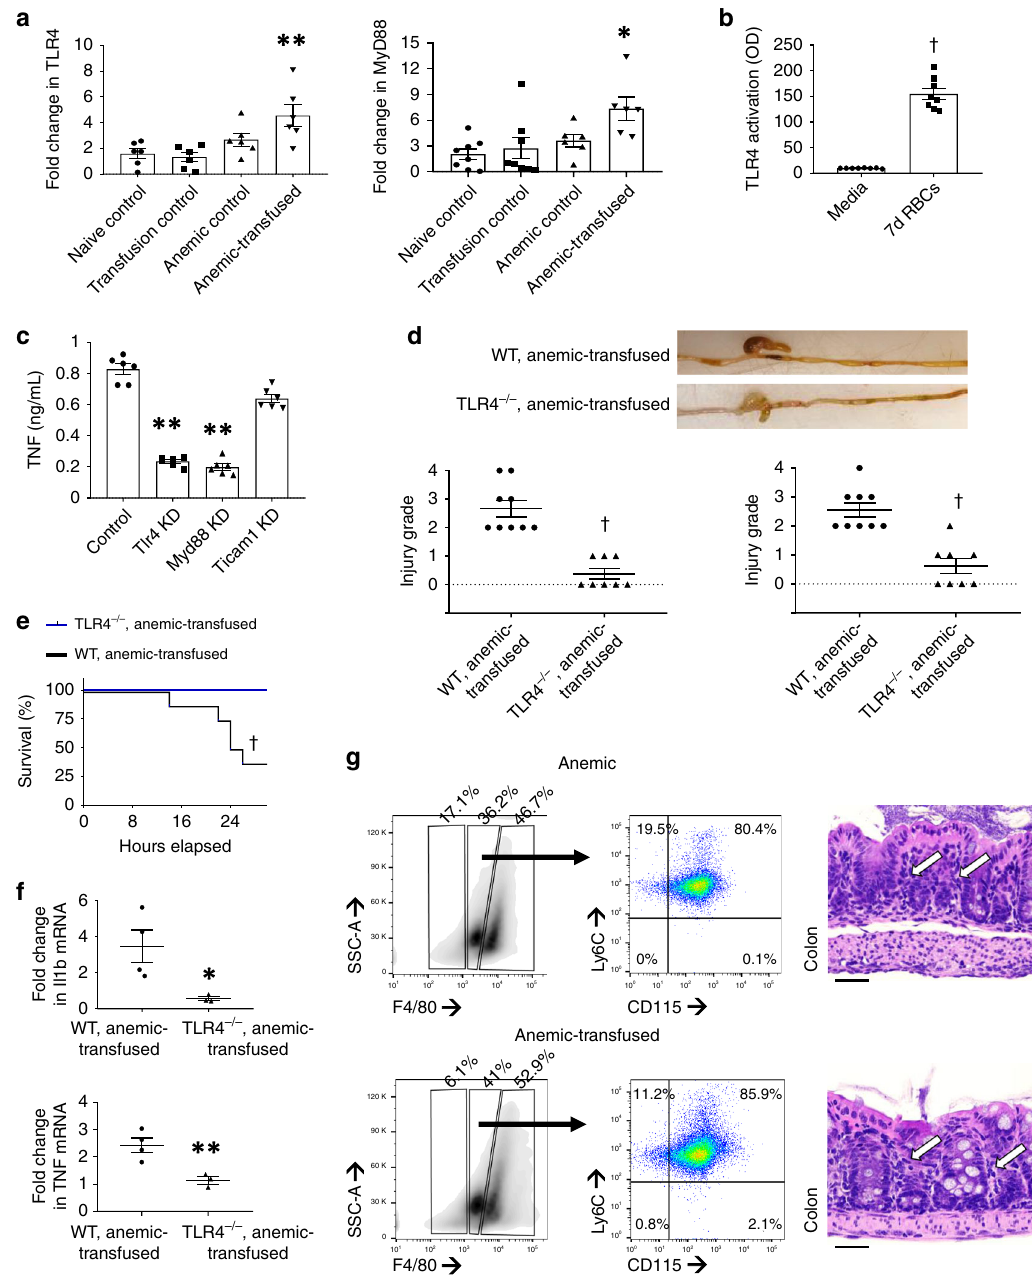
Fig. 6 Red blood cell (RBC) transfusions cause intestinal injury by activating Toll-like receptor-4 (TLR4). a Scatter bar diagrams show fold change in Tlr4 and myeloid differentiation primary response gene 88 (Myd88) mRNA expression in the intestinal tissue from control and anemic-transfused mice. Kruskal – Wallis H test with Dunn ’ s post test, * P < 0.05, ** P < 0.01 vs. naive control. N = 8 mice per group. b RBCs used for transfusion activate TLR4. Scatter bar diagram shows the activation of a reporter gene (secreted embryonic alkaline phosphatase) upon stimulation with 7-day-stored RBCs in TLR4- reporter cells. Mann – Whitney U test, † P < 0.001 vs. naive control. N = 8 different donor mice. c RBCs used for transfusion fail to stimulate TNF production in RAW264.7 macrophages with Tlr4 and Myd88 knockdown. Ticam1 knockdown did not block TNF production. Kruskal – Wallis H test with Dunn ’ s post test, ** P < 0.01 vs. control. N = 8 independent biological replicates per group. d Scatter plots show severity of transfusion-associated bowel injury in anemic-transfused Tlr4 ( − / − ) pups vs. wild-type (WT) littermates, in the ileum (left) and colon (right). Representative photographs above show ileal and colonic injury in WT, but not in the Tlr4 ( − / − ) intestine. N = 8 Tlr4 ( − / − ), 9 WT mice; Mann – Whitney U test, ** P < 0.01, † P < 0.001 vs. WT; e Kaplan – Meier curves summarize survival without intestinal injury in anemic-transfused Tlr4 ( − / − ) pups vs. WT littermates; Mantel – Cox log-rank test, † P < 0.001. f Scatter plots summarize Il1b (top) and Tnf (bottom) expression in ileum from anemic-transfused Tlr4 ( − / − ) pups vs. WT littermates, expressed as fold change over naive control of the same genotype. N = 3 Tlr4 ( − / − ), 4 WT mice; Mann – Whitney U test, * P < 0.05, ** P < 0.01. g Representative fl ow cytometry scatter plots of the CD11b-positive myeloid cell fraction in the anemic and anemic-transfused Tlr4 ( − / − ) intestine show a F4/80 (mid) CD115 ( + ) Ly6C ( + ) cell population. Hematoxylin and eosin (H&E)-stained photomicrographs of the colon from anemic and anemic- transfused Tlr4 ( − / − ) mice show increased cellularity (arrows) in the lamina propria. Scale bars = 50 µ m. N = 8 Tlr4 ( − / − ), 9 WT mice. All scatter plots summarize the data as means ± standard error of the